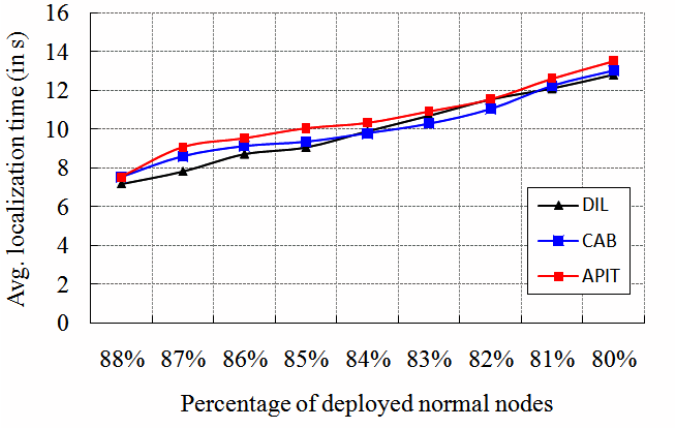
Figure 15. Comparison of localization